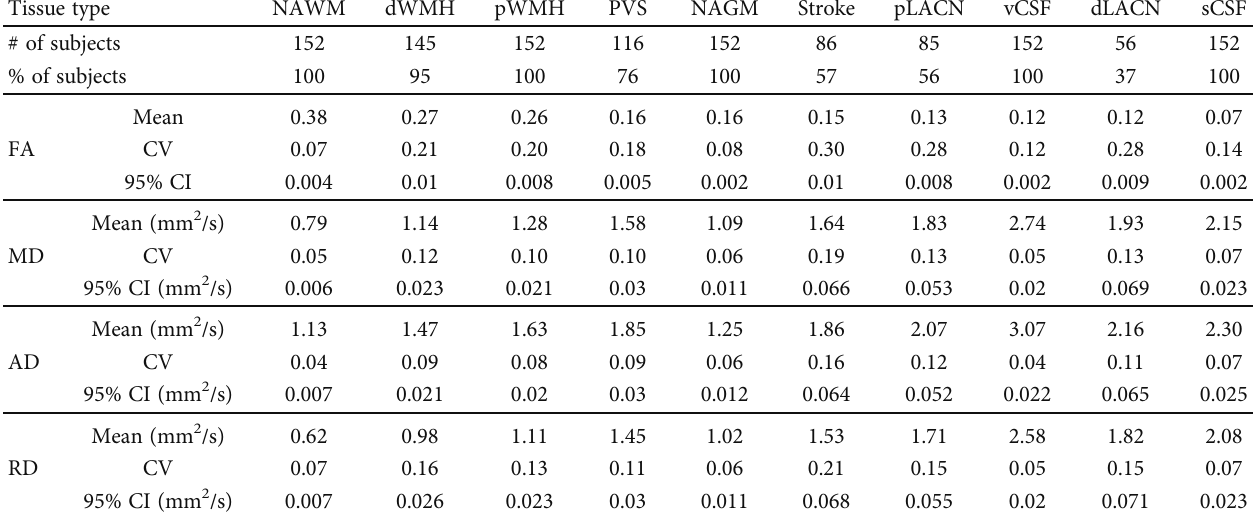
Table 2: Values of the four major DTI metrics measured in the 10 global cerebral tissues/lesions considered in this study using the DTI processing pipeline. Mean, coe ffi cient of variation (CV), and 95% con fi dence interval (CI) of the DTI metrics in each lesion were calculated across the ONDRI CVD subjects who have that speci fi c tissue/lesion. Note that the fi rst two rows provide the number and percentage of the subjects from the ONDRI CVD cohort (152 subjects in total) who have each type of these tissues/lesions. If the volume of a lesion within a subject ’ s brain is smaller than 24 mm 3 , we assumed that the subject does not have that speci fi c lesion